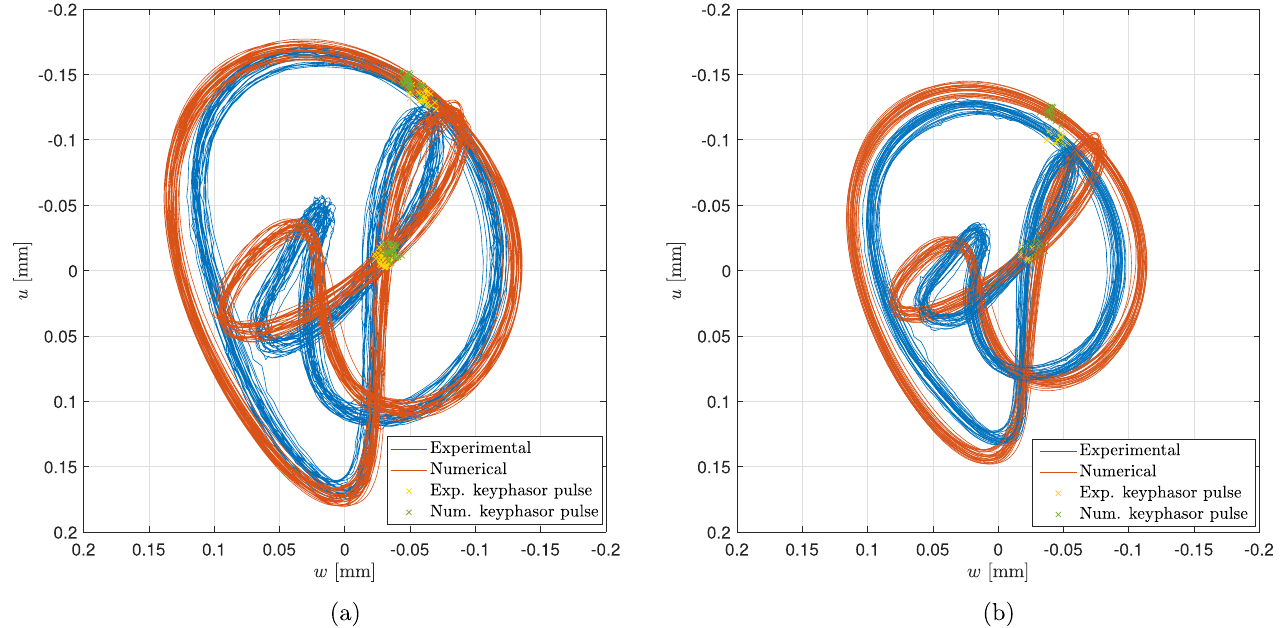
Fig. 5. Experimental-numerical comparison of shaft orbits in response to mass unbalance and two harmonic translations along (cid:126)X 0 and (cid:126)Z 0 within a time interval of 2 s ( ≈ 57 full shaft rotations): (a) Node 15 and (b) Node 19.